Question: What does this figure show? Answer in one sentence.
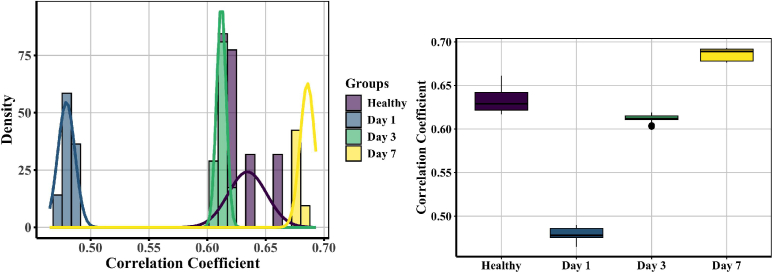
Answer: Pearson correlation coefficient distribution of MSC-EV treatment group.